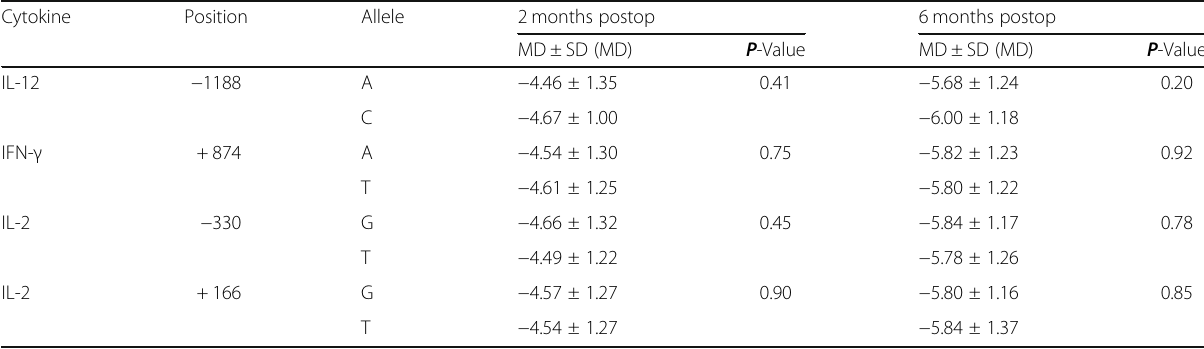
Table 6 Association between cytokine allele frequencies and 2 months or 6 months postop VAS changes in IVDD patients Cytokine